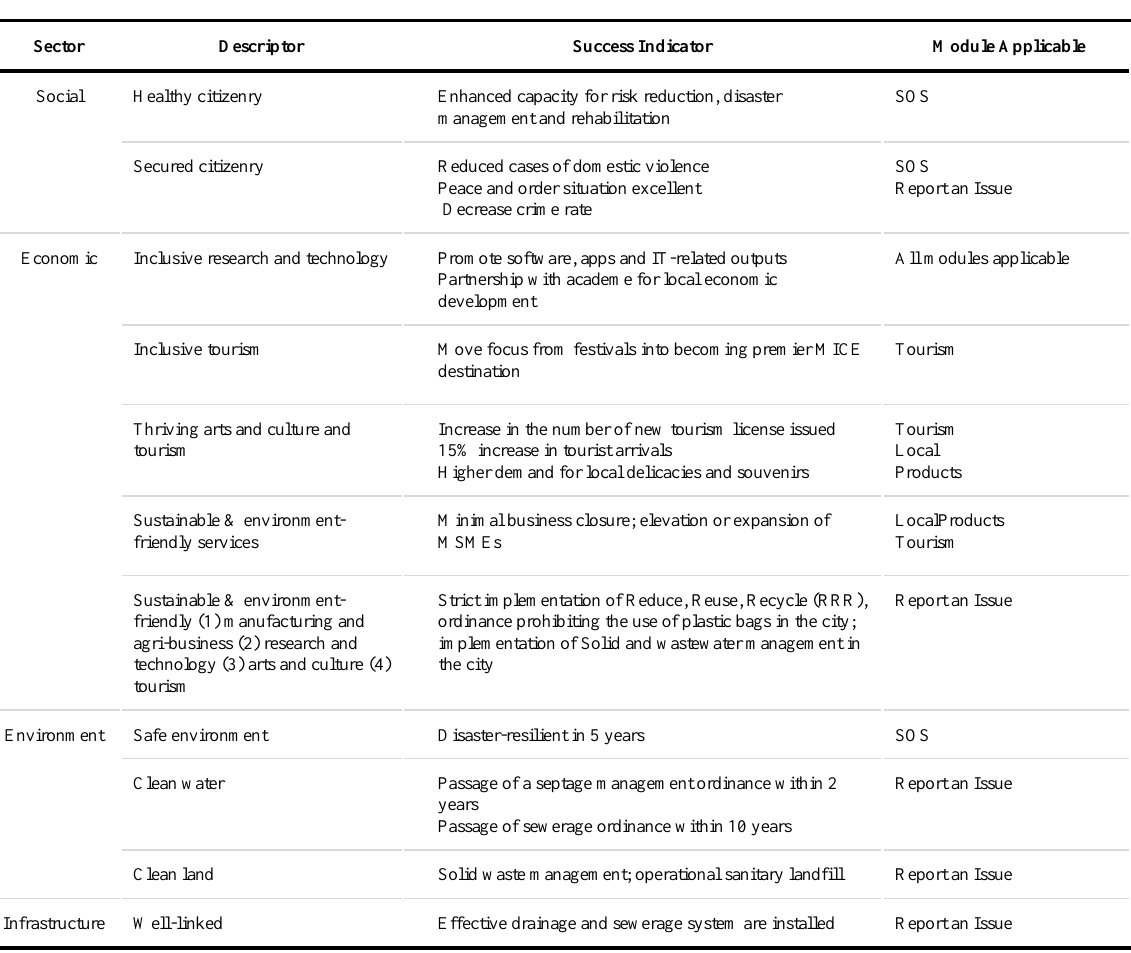
Table 3. 2020-2025 Iloilo City Comprehensive Development Plan & applicable City Connect